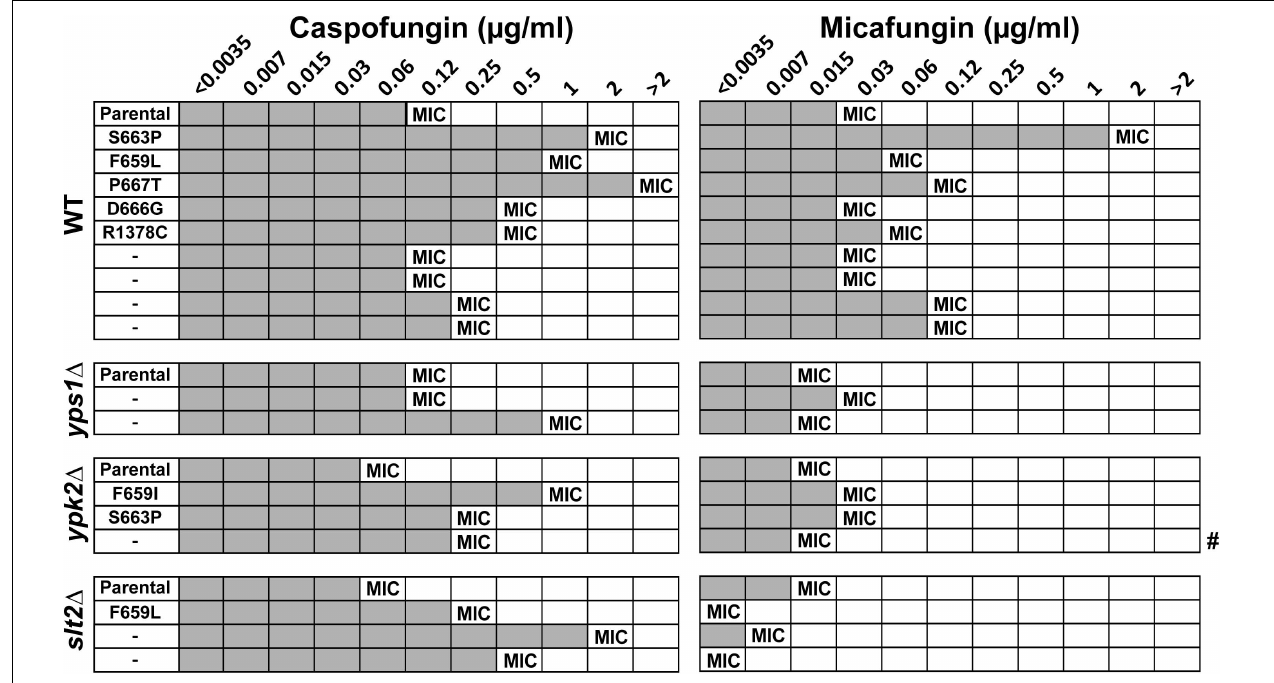
FIGURE 5 | Fungal rebound was predominantly due to strains with elevated MICs to caspofungin but not necessarily micafungin. All strains with fks mutations showed reduced susceptibility to caspofungin relative to the parental strain. Gray shading indicates visible growth in drug-containing media, and the MIC is defined as the lowest concentration at which there is at least a 50% decrease in growth. # indicates one mouse in the ypk2 (cid:49) group, which had to be sacrificed on day 13 and for which day 13 colonies not day 15 were therefore